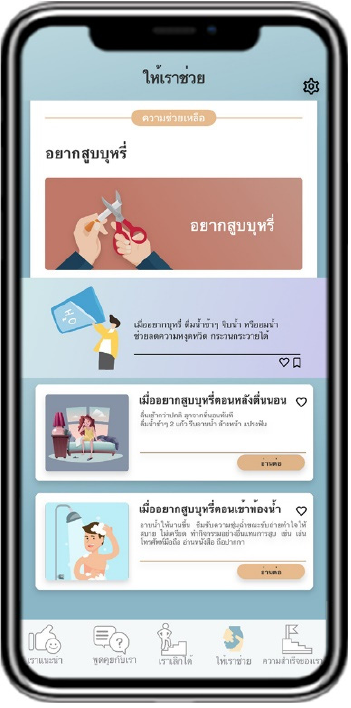
Figure 5. Display screen of Let US Help.